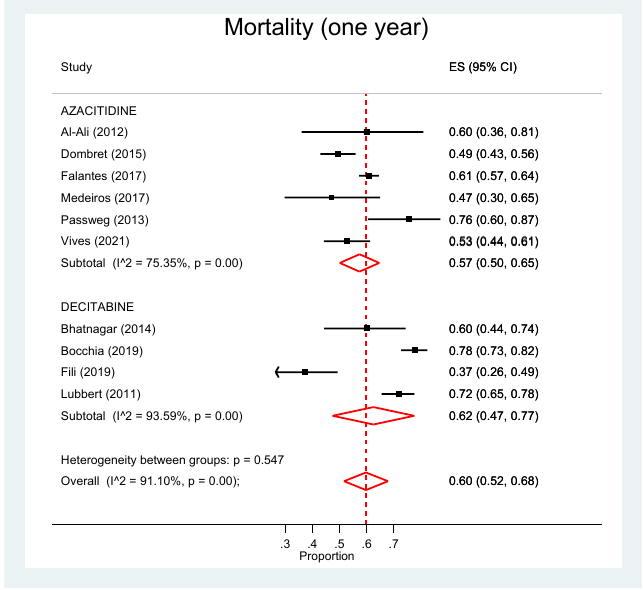
Figure 3. Pooled analysis of 1-year mortality. Figure 4 depicts the median OS of all studies, being 10.04 months for azacitidine (95% CI: 8.36–11.72 months) and 8.79 months for decitabine (95% CI: 7.62–9.96 months), with no statistical significance between them ( p = 0.386).